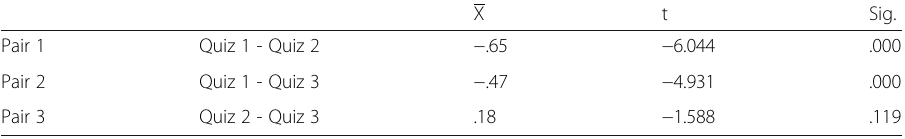
Table 5 EFL learners ’ LC - Formative test (Paired differences- Paired samples t-test)